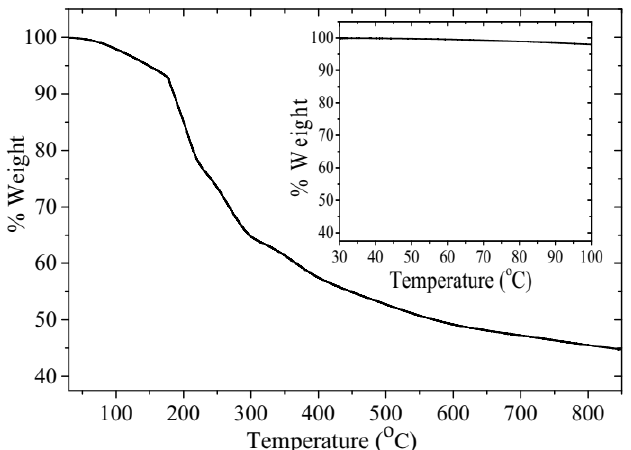
Figure 5. The TGA thermogram of the ternary film in nitrogen obtained at the heating rate of 10 ◦ C / min.